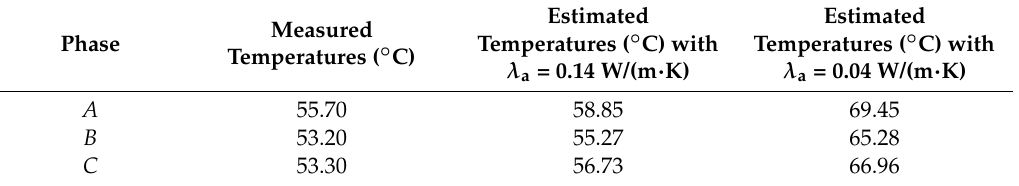
Table 2. Comparison between measured temperatures inside cable joint and estimated results. Measured Phase Temperatures ( ◦ C)